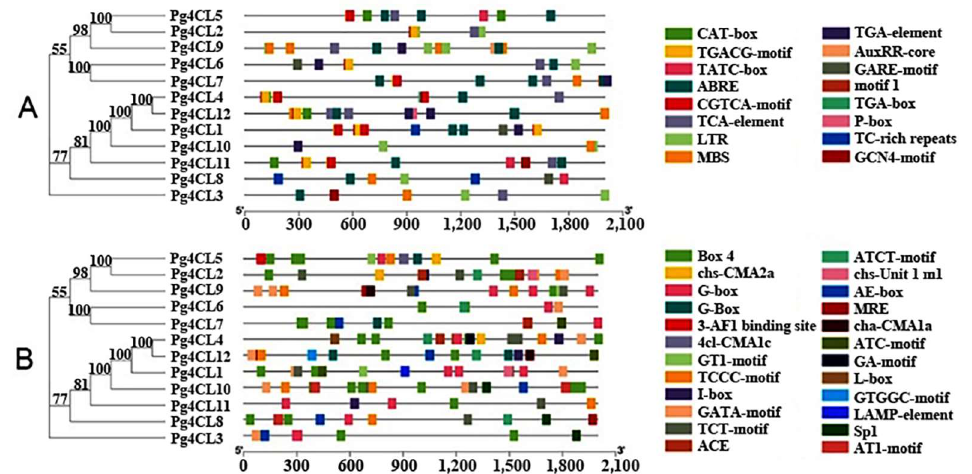
Figure 7. Cis -acting elments of Pg4CLs . ( A ) Hormone, stress, growth and development response elements of Pg4CLs ; ( B ) Light response element of Pg4CLs . Note: abscisic acid response element (ABRE), growth hormone response elements (TGA-element, AuxRR-core, TGA-box), MeJA response elements (CGTCA-motif, TGACG-motif), gibberellin response elements (TATC-box, GARE-motif, P-box), and salicylic acid response elements (TCA-elements).